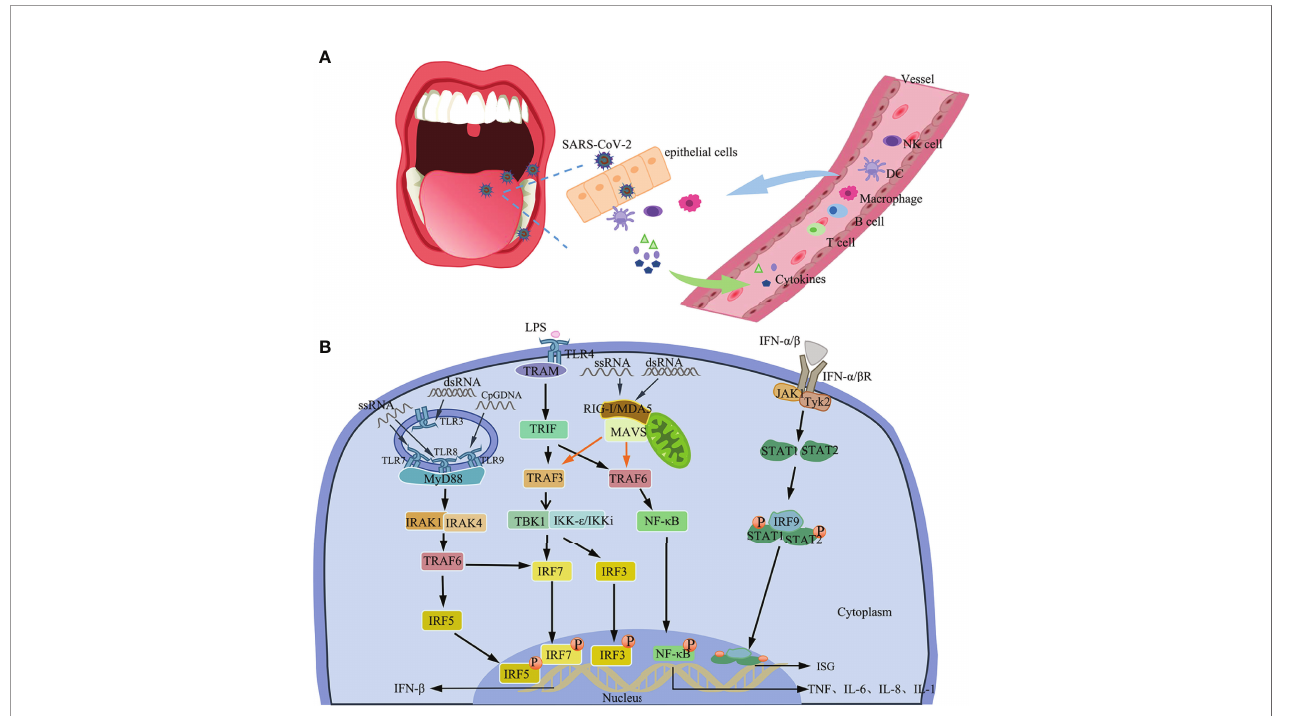
FIGURE 3 | Immune response. (A) Immune response to SARS-CoV-2 in the oral cavity. (B) IFN induction and the positive feedback signaling pathway. The production of IFN- b by TLR4-TBK1/IKKi, TLR7/8/9-MyD88/IRAK1/IRAK4, and RIG-I/MDA5/MAVS signals. IFN-1 induces the expression of ISG via the Tyk2/JAK1/ STAT signaling pathway by binding to